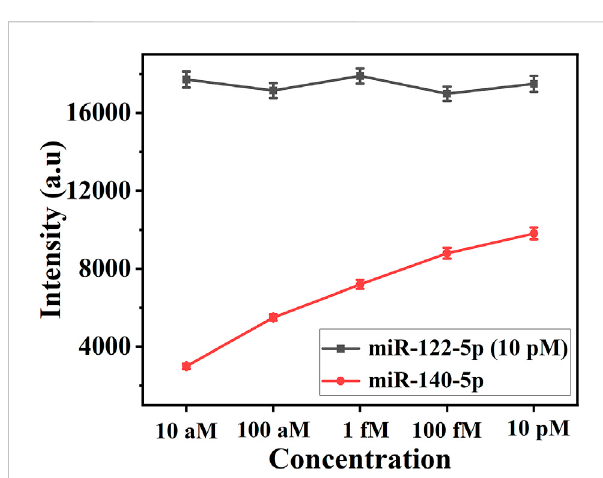
FIGURE 4 Line chart of SERS intensities at 1,133 cm − 1 and 1,602 cm − 1 . The concentration: (1) 10 pM miR-122-5p +10 aM miR-140-5p; (2) 10 pM miR-122-5p +1 fM miR-140-5p; (3) 10 pM miR-122-5p +100 fM